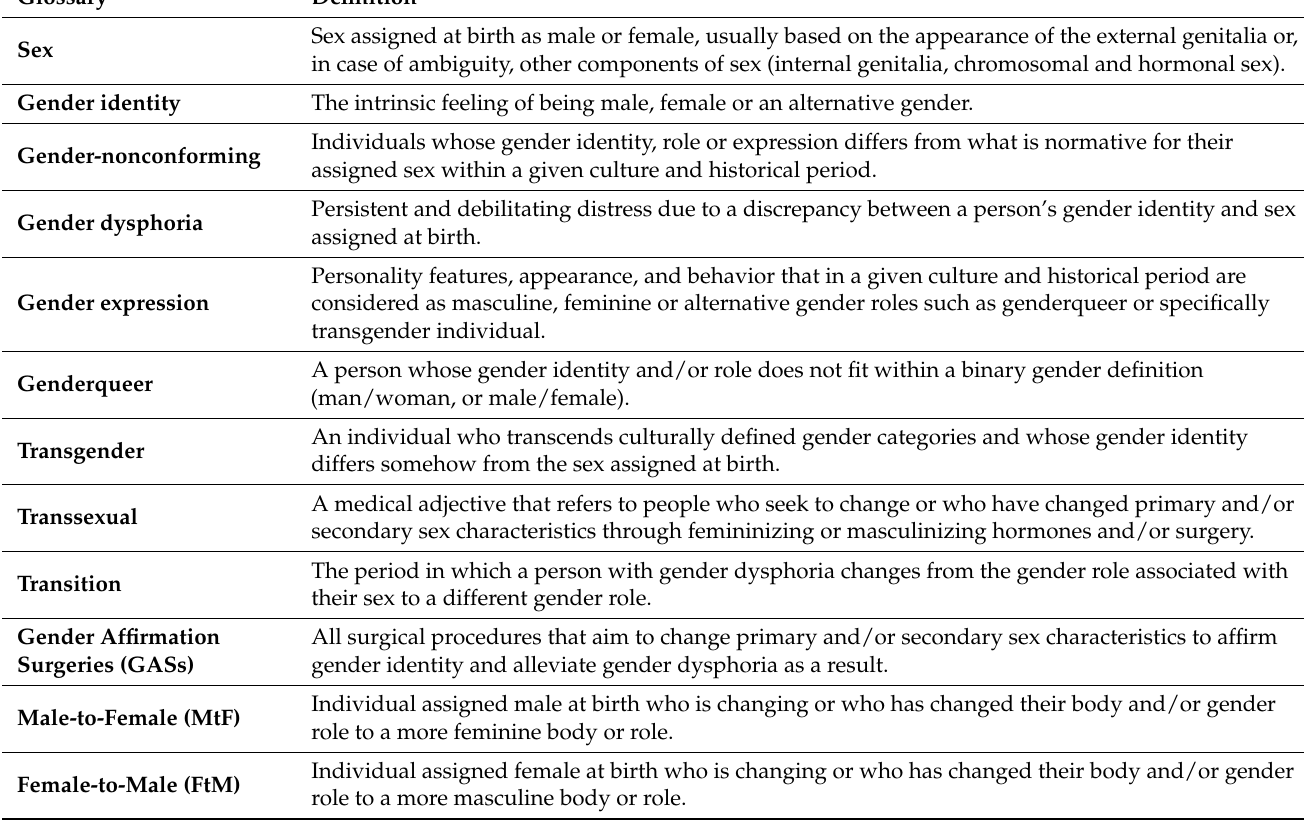
Table 1. Glossary and definitions [1].